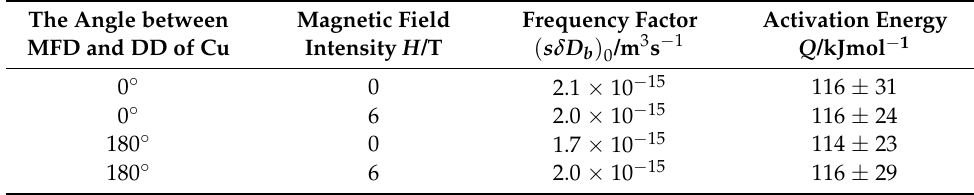
Table 3. Frequency factor ( s δ D b ) and activation energy Q (standard deviation for 95% confidence) 0 for copper grain boundary diffusivities in cobalt under a nonmagnetic field and a 6-T magnetic field. The Angle between MFD and DD of